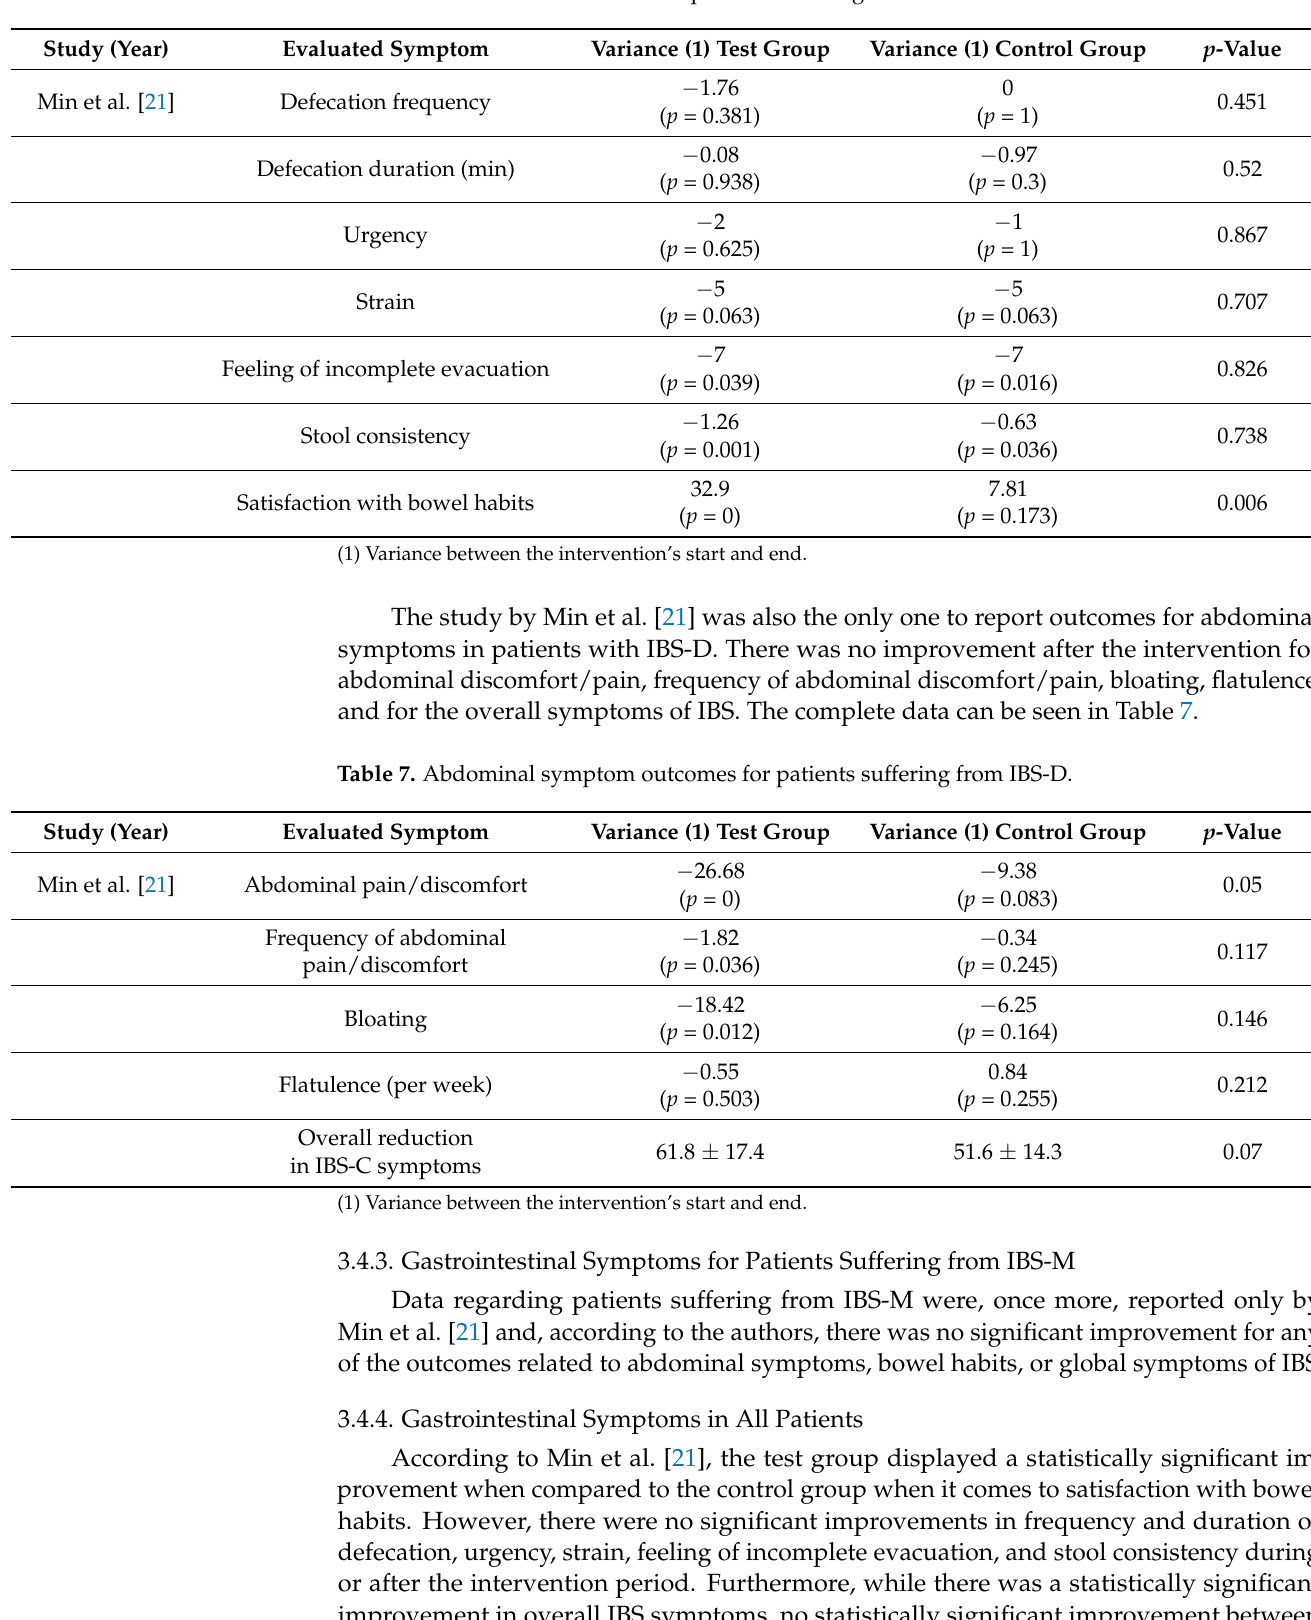
Table 6. Bowel habits outcomes for patients suffering from IBS-D.